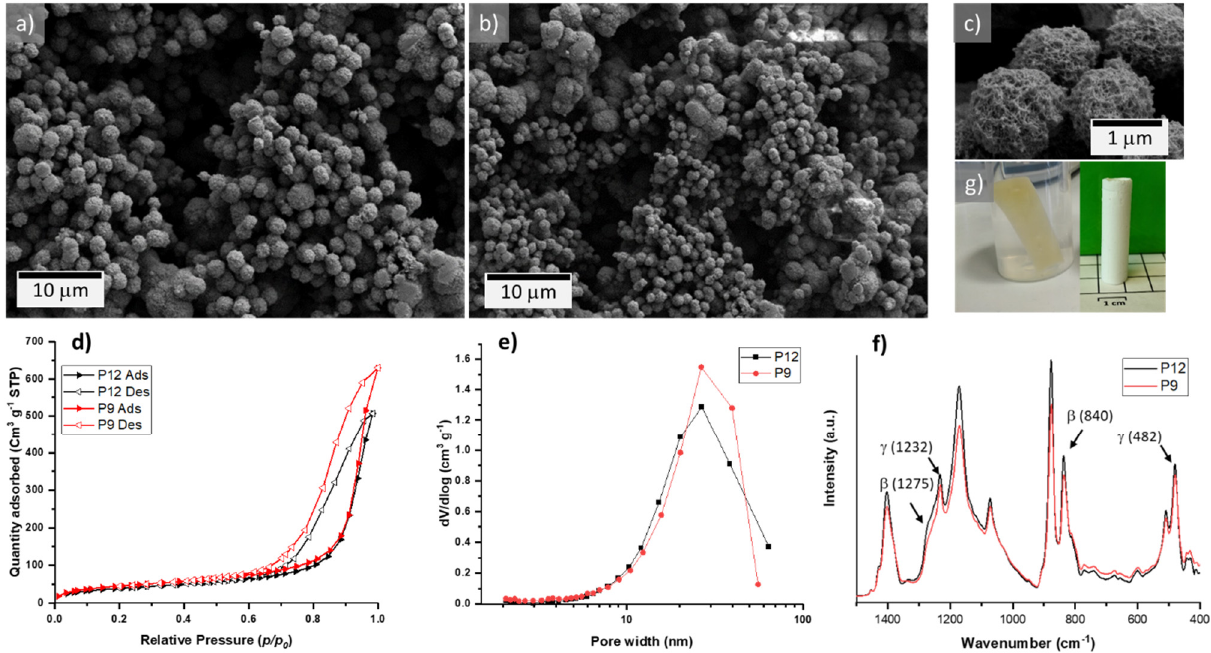
Figure 1. ( a , b ) SEM micrographs of the P12 ( a ) and P9 ( b ) aerogels, respectively; ( c ) spherulitic particles (P12) of the PVDF aerogels; ( d ) nitrogen sorption isotherms; ( e ) BJH pore size distribution plots; ( f ) FTIR spectra; and ( g ) obtained P12 wet gel and its aerogel counterpart upon supercritical drying.